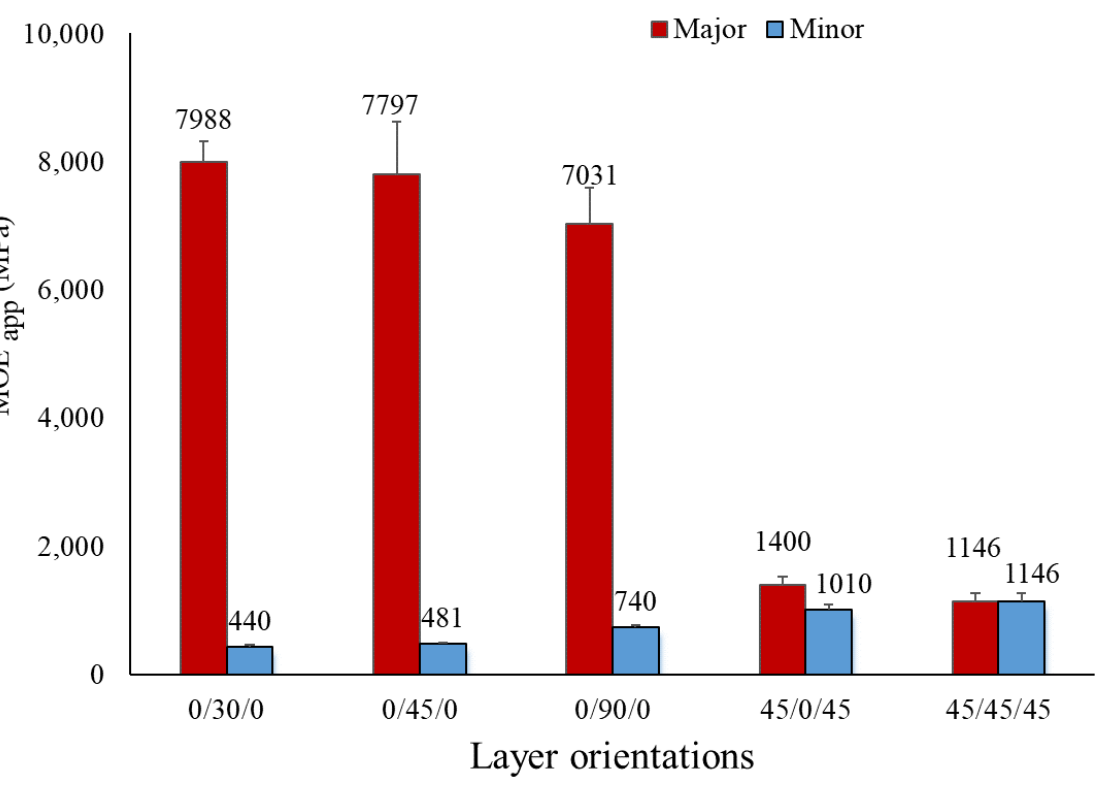
Figure 3. Modulus of elasticity (MOE app ) of CLTs in both major and minor axes.